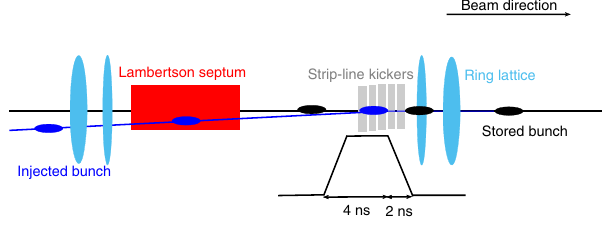
FIG. 2. Schematic diagram of a uniform filling pattern of HEPS, the circles filling with black present the circulating bunches in the storage ring, while the circles filling with blue stands for the injected bunch. A time interval between the circulating bunches is 6